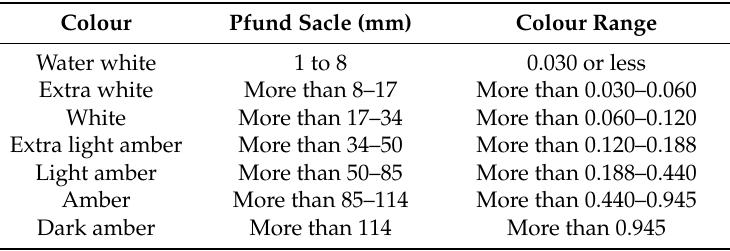
Table 1. Pfund scale for determination of honey